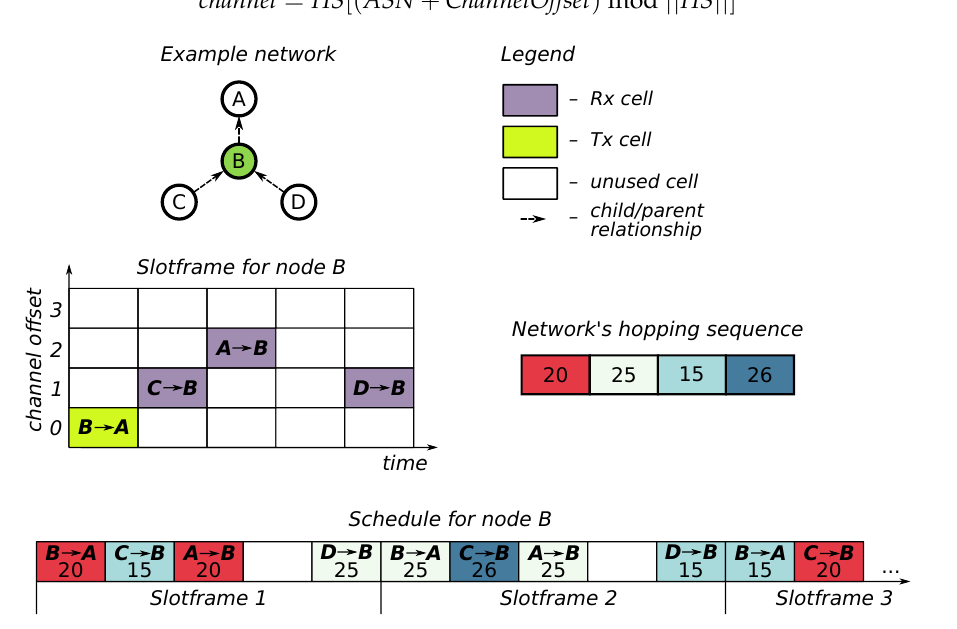
Figure 1. Overview of TSCH